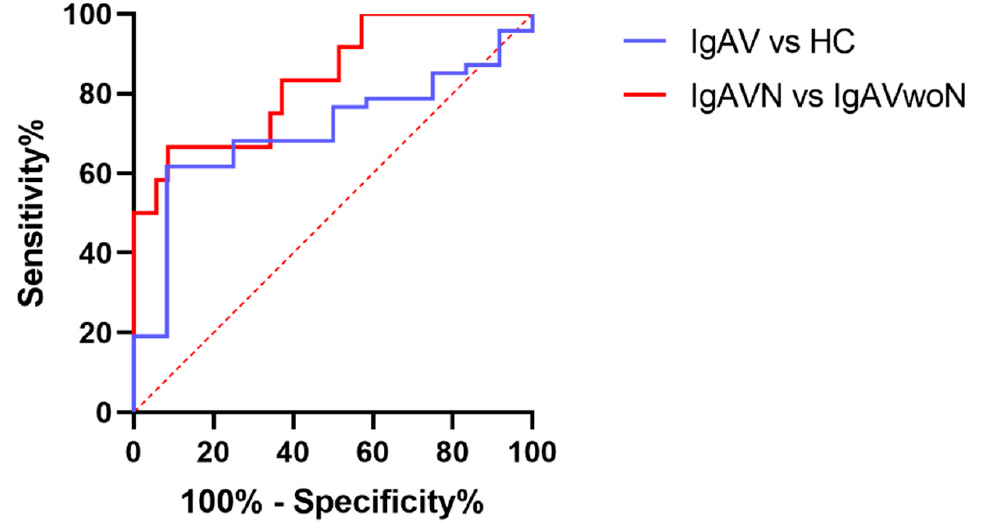
Figure 5. Receiver operating characteristic (ROC) curve analyses. ROC curves for the ability of urinary IgA to discriminate IgAV patients from HC, and IgAVN from IgAVwoN.